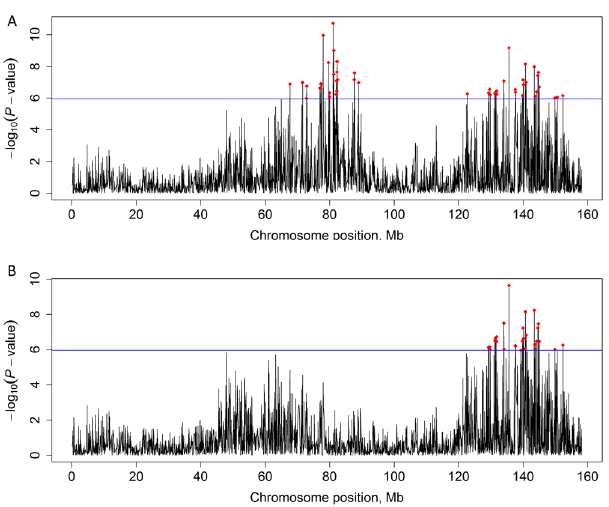
Figure 1. The − log ( P -value) of SNPs on chromsosme 1 for IFLc before ( A ) and after ( B ) correcting the most significant SNP in Nordic Holsteins. The horizontal line indicates the genome-wide significance level ( − log10( P -value) = 5.95). Genome-wide significant SNPs were hilighted using red